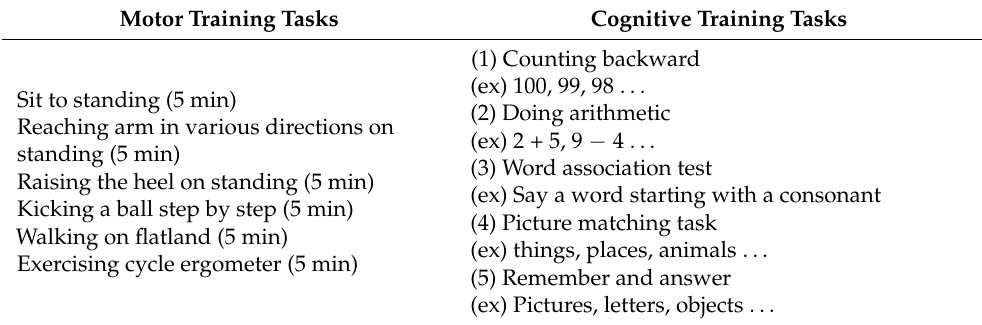
Table 1. Dual-task training